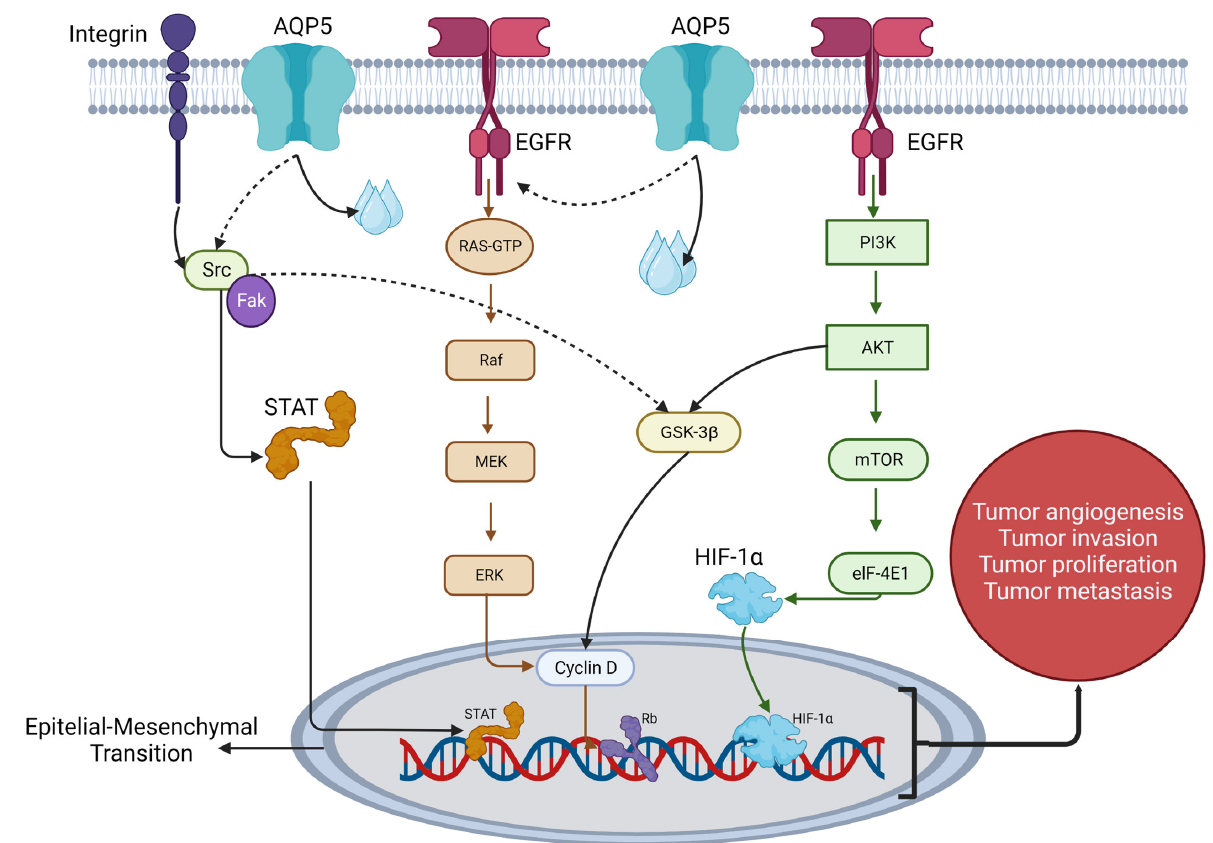
Figure 2. Signaling pathways associated with AQP5 in lung adenocarcinoma. AQP5 affects the activation of the extracellular kinase receptor (ERK1/2) pathway by activating the epidermal growth factor receptor (EGFR). In addition, AQP5 phosphorylated on Ser156 bind the SH3 domain of Src. In this way AQP5 participates in tumor invasion, metastasis, angiogenesis, and prolifera- tion through a variety of complex signaling pathways. AQP5, aquaporin 5; EGFR, epidermal growth factor receptor; PI3K, Phosphoinositide 3-kinase; PDK1, 3-phosphoinositide-dependent protein kinase-1; AKT, protein kinase B; Raf, rapidly accelerated fibrosarcoma; MEK, mitogen- activated protein kinase; ERK, extracellular-signal-regulated kinase [39,40]. Created with BioRen- der.com.